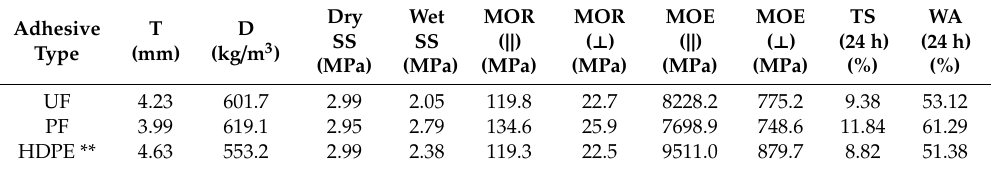
Table 8. Physical and mechanical properties of plywood panels bonded with di ff erent adhesives